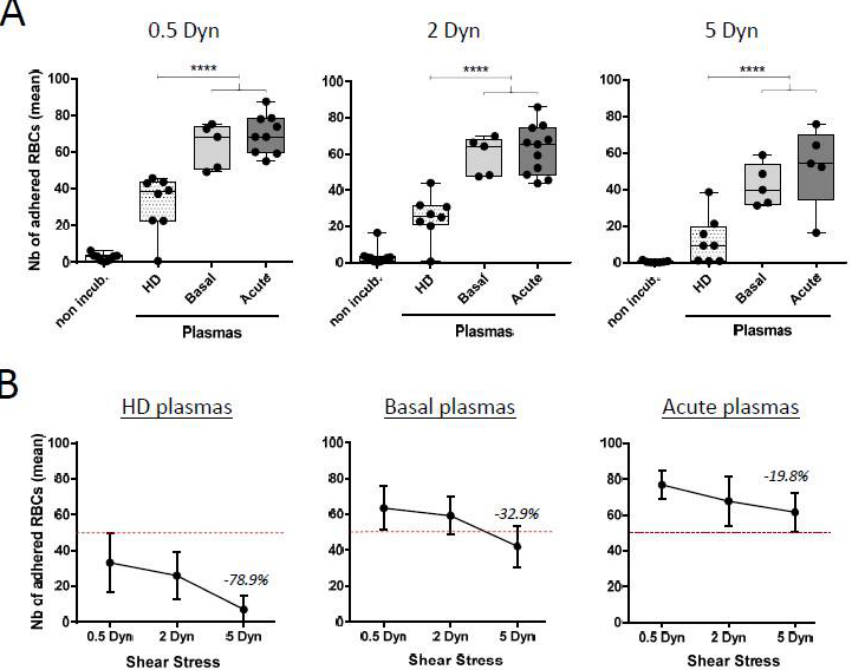
Figure 3. Accelerated senescence of AA RBCs after co-incubations with SCD plasmas induce adhesion to thrombospondin. ( A ) The flowing adhesion of donor AA RBCs from blood units was tested after co-incubations with plasmas from SCD patients (the respective “basal” and “acute” clinical conditions) or from healthy donors (“HD”), with TSP immobilized in microslides. The RBCs were perfused through the microslide using the VenaFlux software. Washouts were made at increasing physiologic shear stresses (0.5, 2 and 5 Dyn/cm 2 ) conditions for 5 min each. Adherent red cells were counted in five representative areas. The mean values obtained for the adhesion of non-incubated AA RBCs for the respective shear stress 0.5, 2 and 5 Dyn were 2.6 ± 1.9, 3.5 ± 4.7 and 0.4 ± 0.5. The mean values obtained for adhered RBCs incubated with “HD” plasmas were 31.9 ± 15.5, 25.2 ± 12.3 and 12.1 ± 13, respectively. Results obtained for adhered RBCs incubated with “basal” plasmas were 63.4 ± 12.1, 59.2 ± 10.5 and 42.2 ± 11.5, respectively; and for adhered RBCs incubated with “acute” plasmas: 69.8 ± 10.6, 62.2 ± 16.6 and 52.6 ± 22.3, respectively. (**** p < 0.0001; one way ANOVA) ( B ) The strength of RBC adhesion to TSP under physiologic flow conditions in microslides was quantified using the mean results of RBC adhesion obtained in (A). The mean results for adhered RBCs after contact with “HD” plasmas were the following: 33.2 ± 16, 25.9 ± 13 and 7.1 ± 8 for the respective shear stress values 0.5, 2 and 5 Dyn. Results for adhered RBCs after contact with “basal” plasmas were the following: 63.4 ± 12 (0.5 Dyn), 59.2 ± 10 (2 Dyn) and 42.2 ± 12 (5 Dyn). The mean results for adhered RBCs after contact with “acute” plasmas were 76.9 ± 8 (0.5 Dyn), 67.8 ± 14 (2 Dyn) and 61.6 ± 11 (5 Dyn). A dotted line is indicated on the three graphs, arbitrary positioned upper to the maximal values for 0.5 Dyn for “HD” plasmas (mean + upper SD) to demonstrate the differences in the adhesion results for the different categories of plasmas. Numbers in percentage indicate on the graphs the respective changes obtained for each category of plasma between the 0.5 Dyn and the 5 Dyn relative shear stress applied in the test. Decreases in the number of adhered RBCs to TSP were –78.9%, –32.9% and –19.8%, respectively. Results represent the mean of five to seven independent